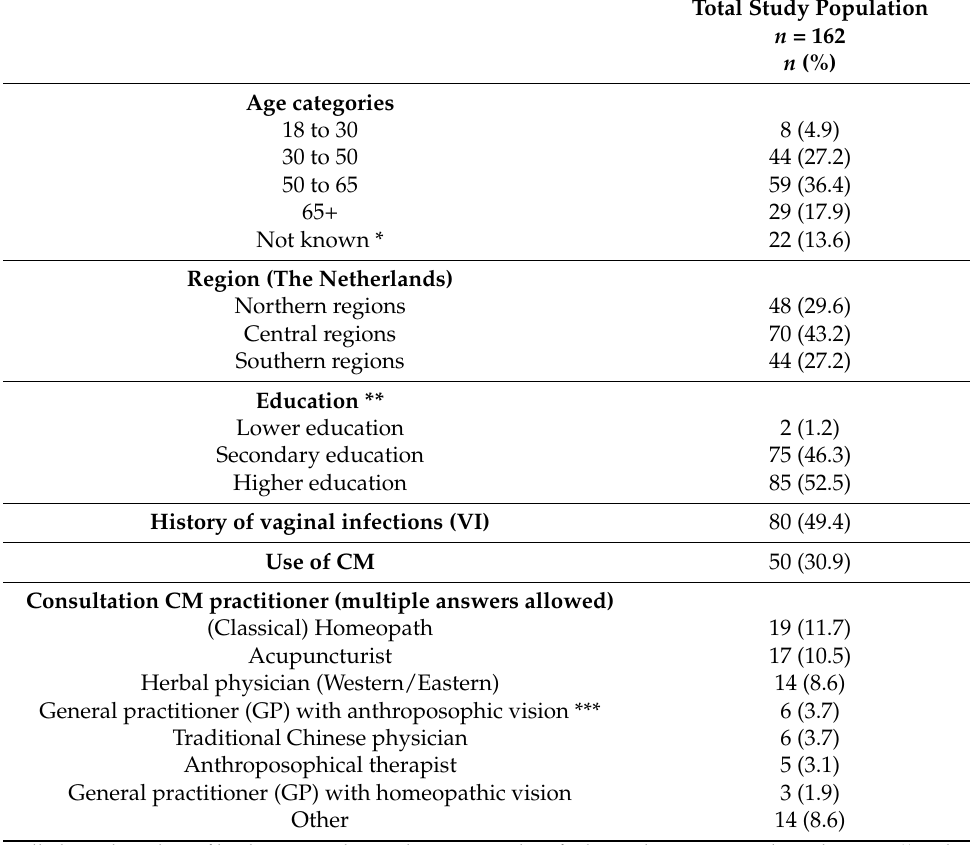
Table 1. Baseline characteristic and use of complementary medicine